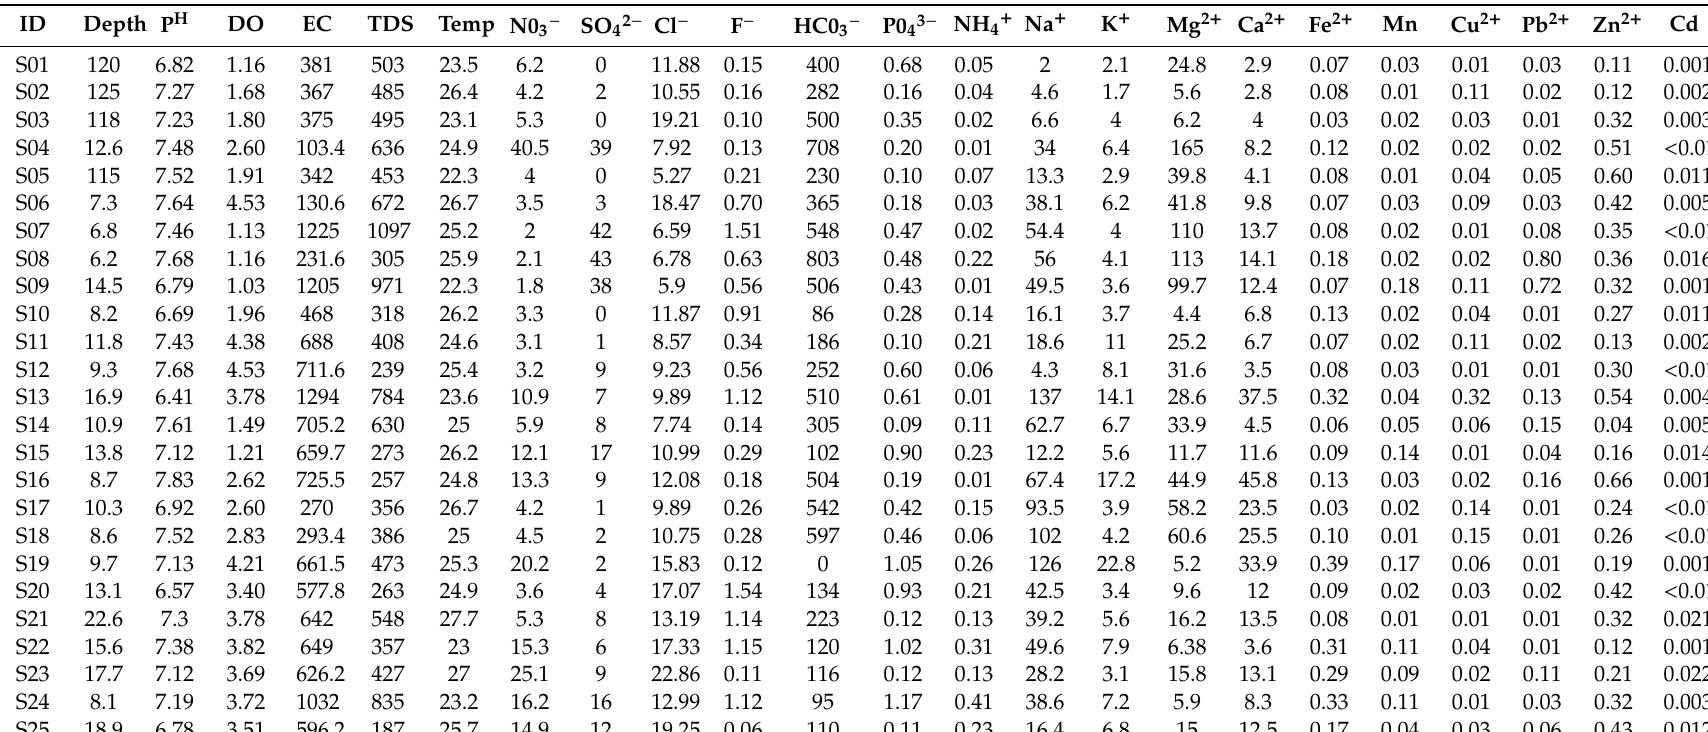
Table A2. Water quality parameter of groundwater for the dry